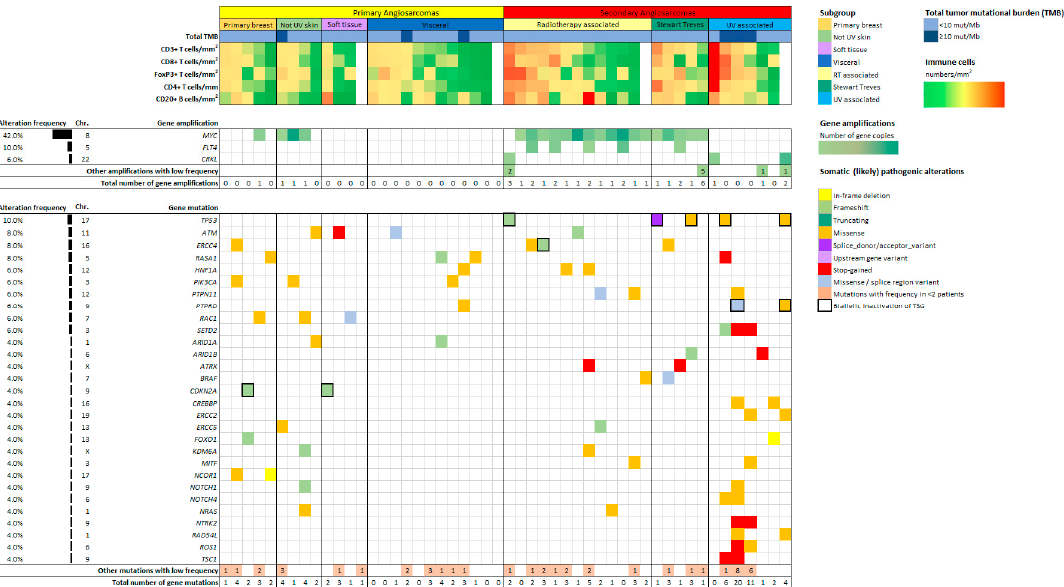
Figure 3. Genomic and immunological landscape of 50 angiosarcoma tumor samples. (Likely) Pathogenic mutations and gene amplifications detected in ≥ 2 tumors are reflected in this figure. Cell densities for CD3 + , CD8 + , FoxP3 + , CD4 + T cells and CD20 + B cells are reflected based on the number of cells/mm 2 .